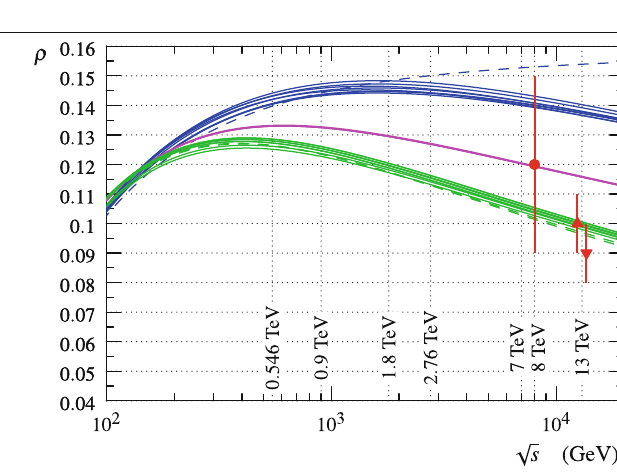
Fig. 20 Predictions of COMPETE models [48] for pp interactions. Each model is represented by one line (see legend). The red points rep- resent the reference TOTEM measurements. The σ tot point at 13TeV corresponds to the weighted average in Eq. (21). The two ρ points at